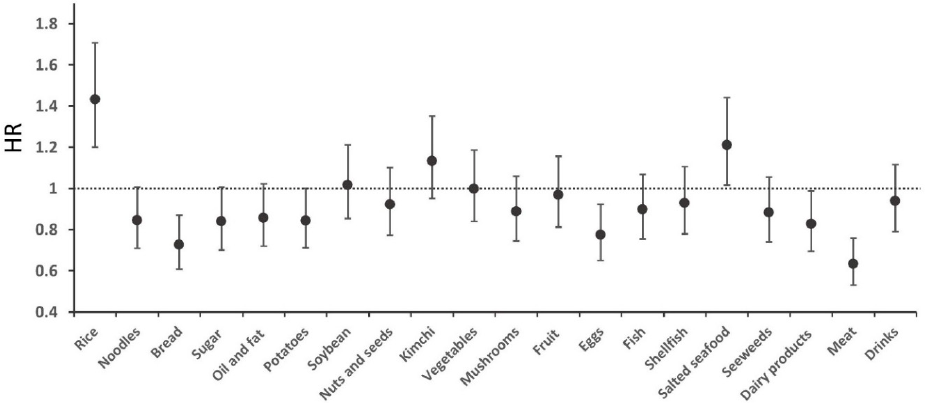
Figure 1. Hazard ratios of the 20 food groups for incident hypertension (HTN). Circles and bars indicate hazard ratios with 95% confidence intervals. The hazard ratios (with 95% confidence intervals) for incident hypertension (HTN) are shown for comparisons of the top and bottom quintile (Q5 vs. Q1). Individual food group intakes were estimated after controlling for total energy using the residual method.